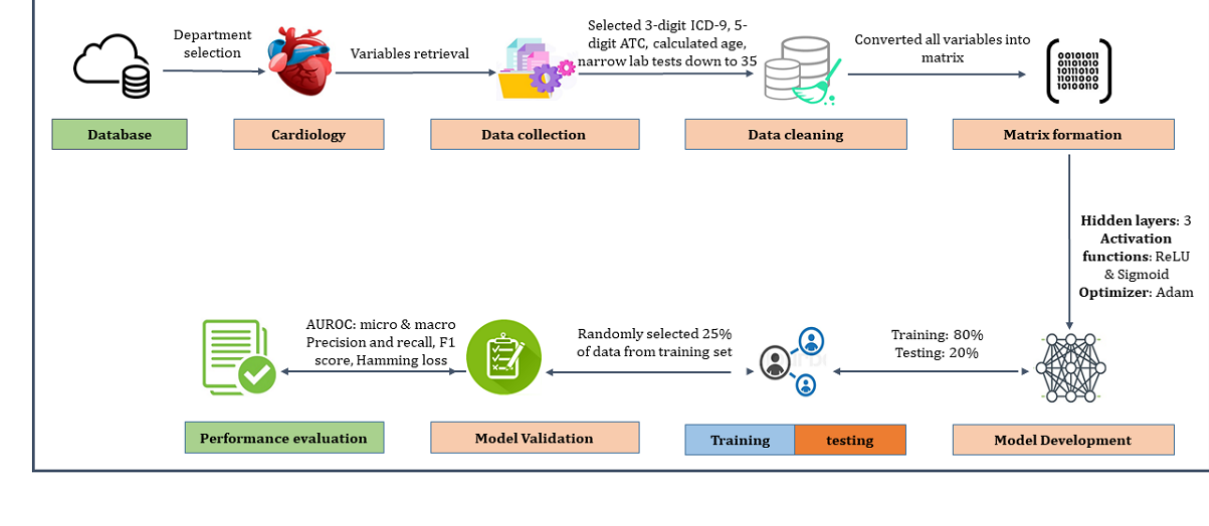
Figure 1. Overall study design.